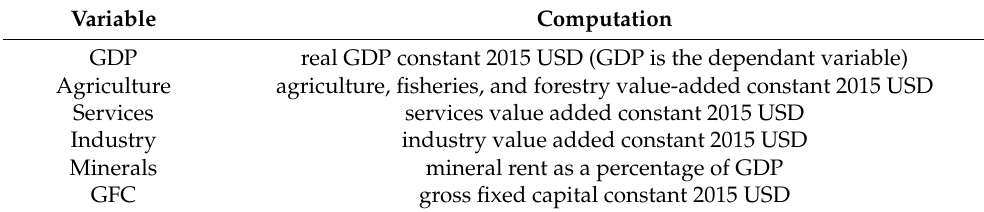
Table 2. Variables of interest. Variable Computation GDP real GDP constant 2015 USD (GDP is the dependant variable) Agriculture agriculture, fisheries, and forestry value-added constant 2015 USD Services services value added constant 2015 USD Industry industry value added constant 2015 USD Minerals mineral rent as a percentage of GDP GFC gross fixed capital constant 2015 USD Source: World Bank database (2022)